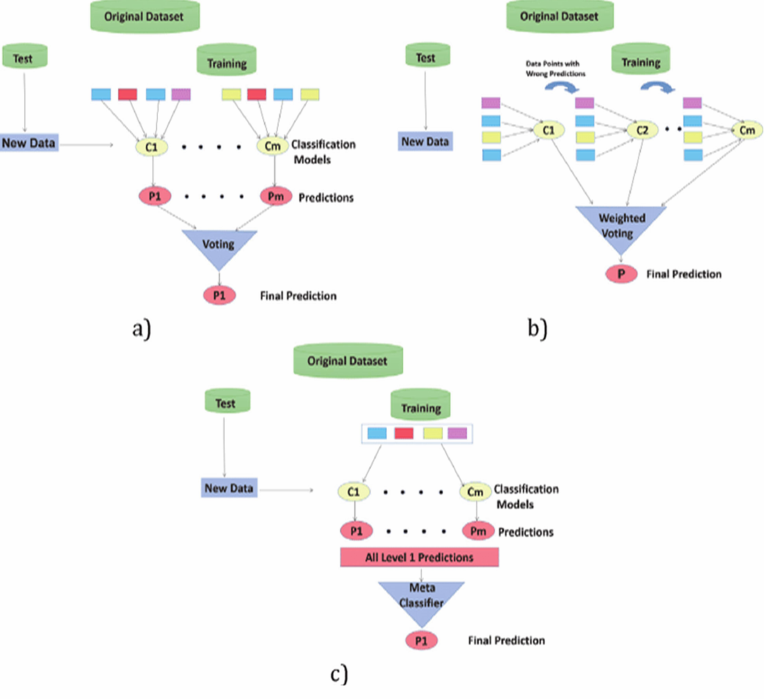
Figure 9. A comparison between ensemble learning methods: ( a ) Bagging Method. ( b ) Boosting Method. ( c ) Stacking Method. “Adapted from [52]. (2020), Kiyak,